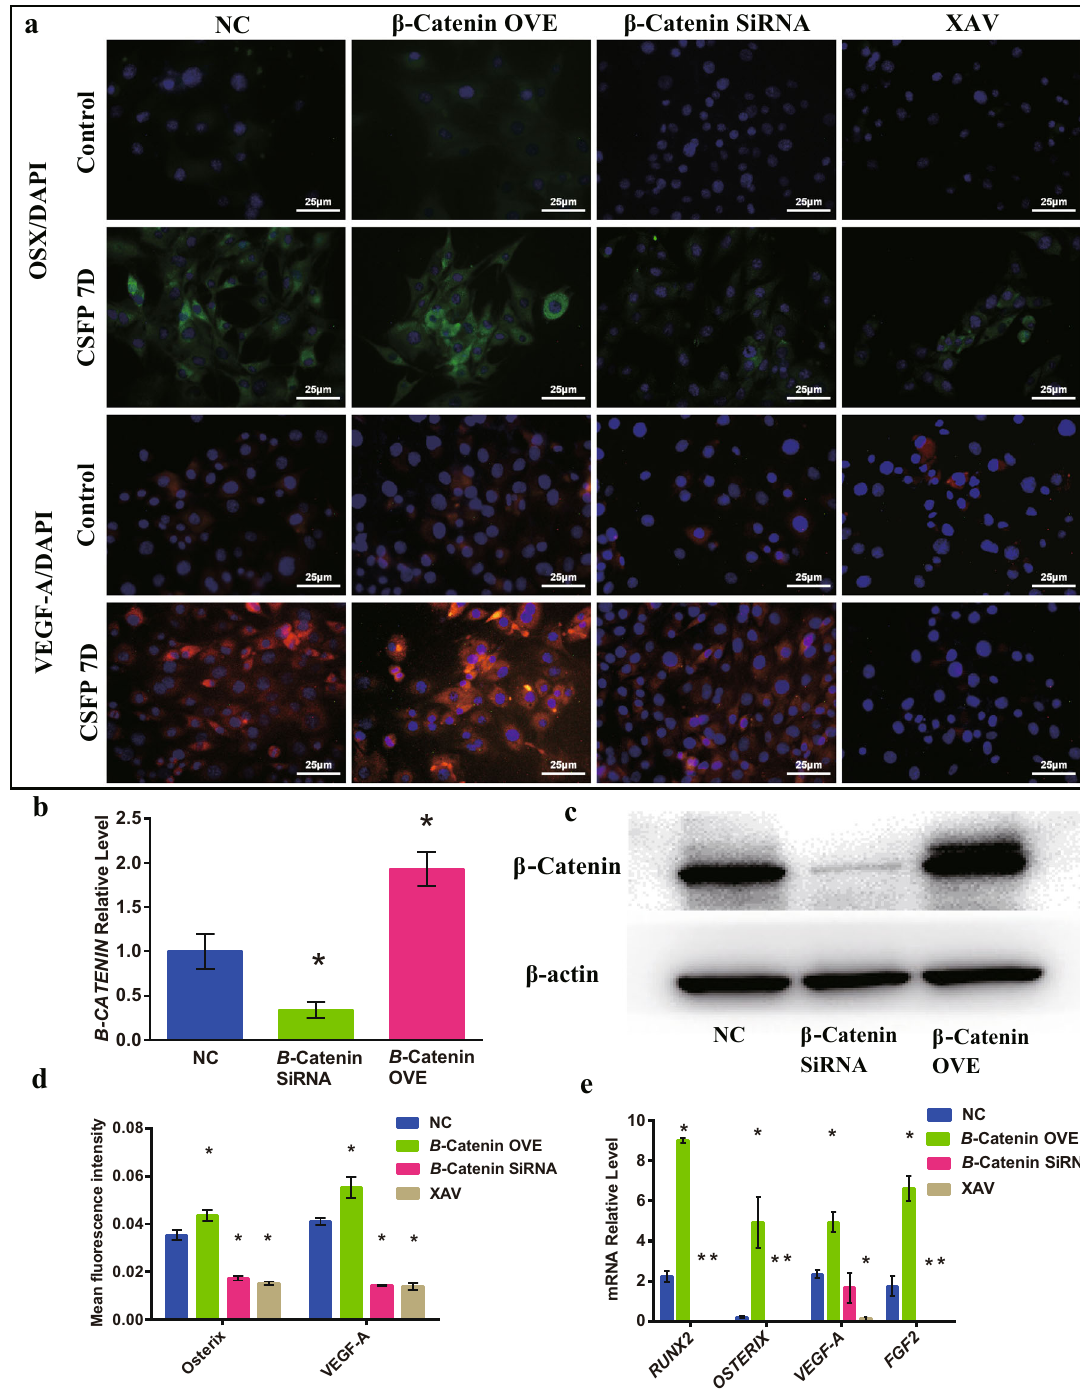
Fig. 3 CSFP promoted the osteogenic and angiogenic abilities of MSC through the regulation of β -Catenin. a IF staining of Osterix and VEGF-A. b β -CATENIN mRNA expression levels in the normal control (NC), β -Catenin-knockdown ( β -Catenin siRNA), and β -Catenin- overexpression ( β -Catenin OVE) cell models. c β -Catenin protein expression levels in the NC, β -Catenin siRNA, and β -Catenin OVE cell models. d The mean fl uorescence intensity of Osterix and VEGF-A in the β -Catenin OVE group was statistically higher than that of the NC group. Conversely, those in the β -Catenin siRNA and β -Catenin-inhibition (XAV) groups were statistically lower than that of the NC group. e QRT-PCR analysis. Data are presented as mean ± SEM, and * P < 0.05 (experimental groups vs NC immuno fl uorescent staining revealed that the expression and and osteoblast differentiation (Fig. 6). These results suggested that localization trends of β -Catenin and Osterix were consistent, and CSFP could promote the expression levels of osteogenic and the Pearson ’ s correlation value analyzed by ImageJ was about angiogenic markers, thereby promoting the bone and blood 0.97, indicating a strong positive correlation between β -Catenin vessel formation of TEL through the regulation of β -Catenin.